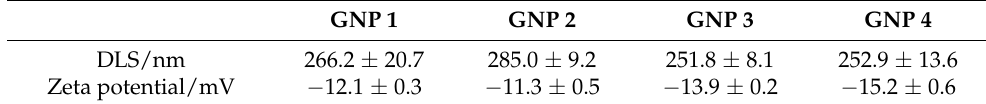
Figure 3. Structures of Compounds 1–4 and TEM characterization of GNPs 1–4 . Table 1. Hydrodynamic diameter and zeta potential of GNPs 1–4